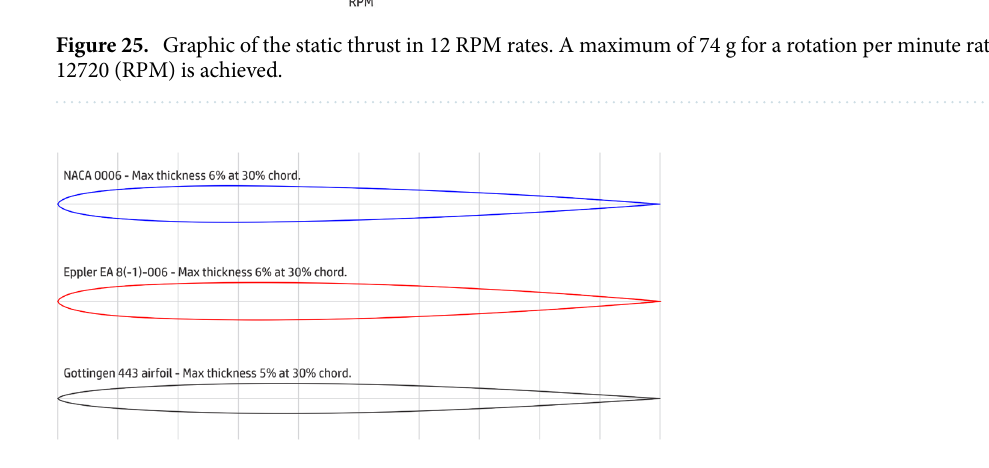
Figure 26. Profiles tested for the final